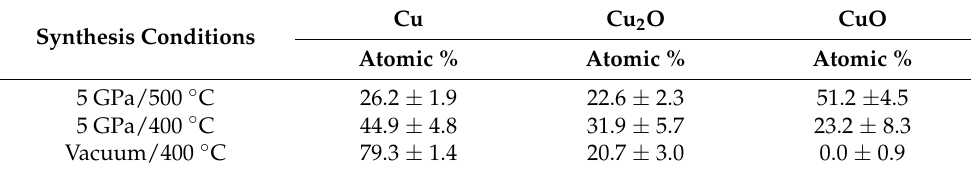
Table 2. XANES analysis for Cu valency of MOF-derived Cu@C materials.